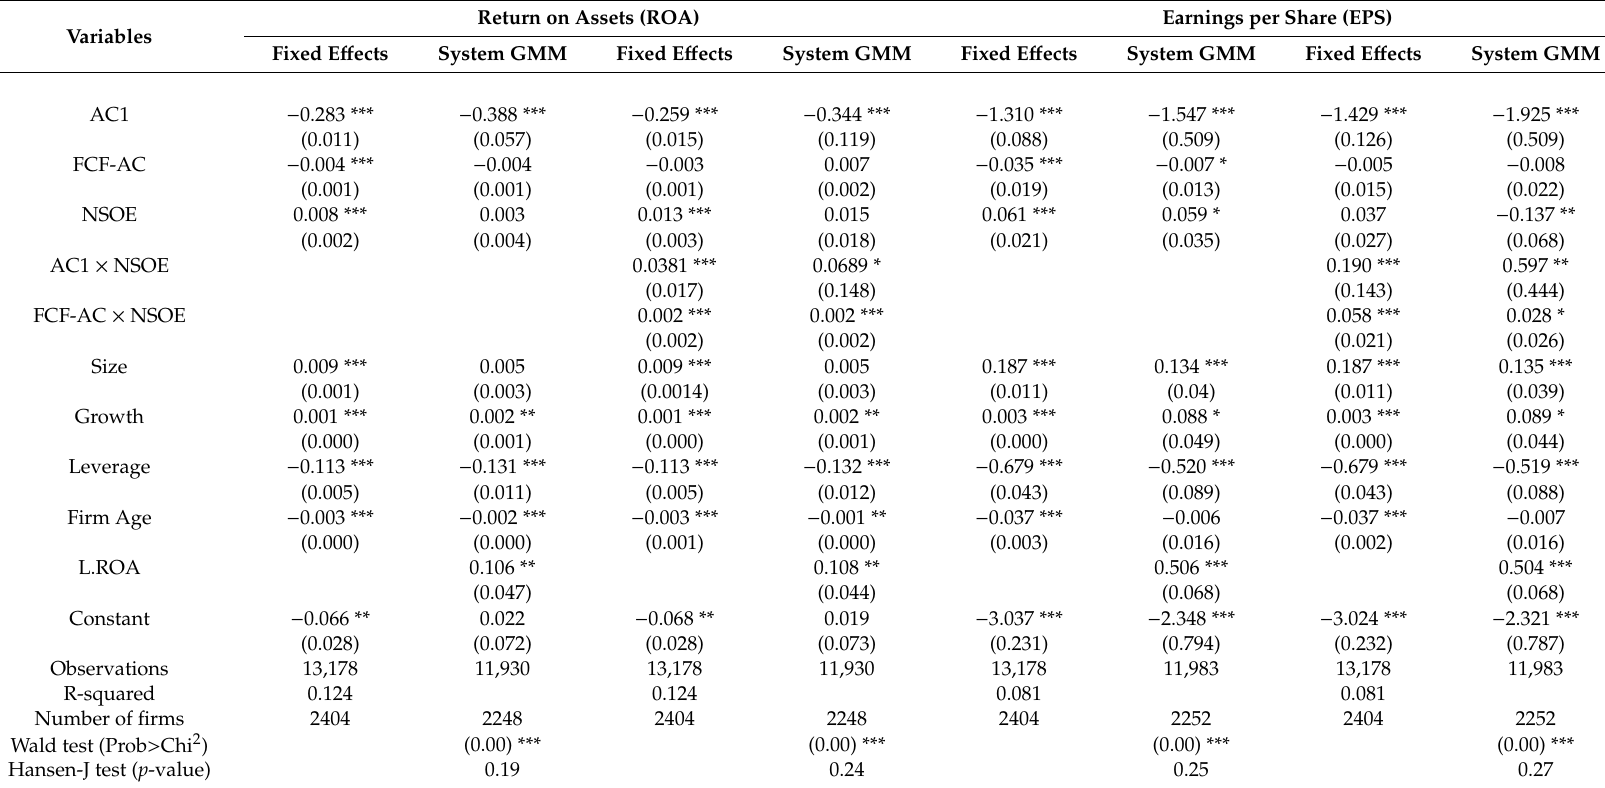
Table 9. Moderating e ff ect of ownership type (NSOE) on agency costs and firm